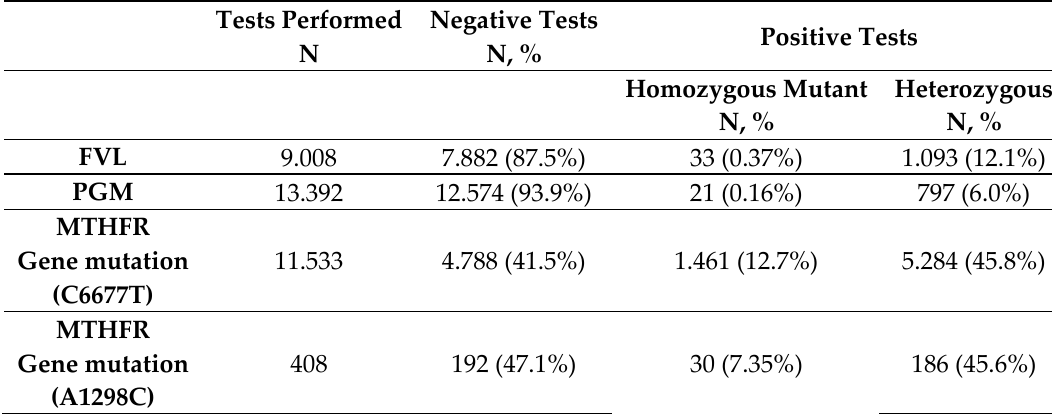
Table 1. Genetic tests results